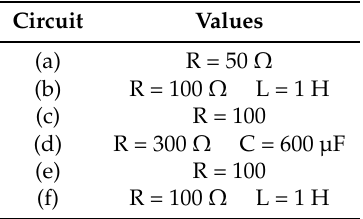
Table 11. Parameters of real components in the test